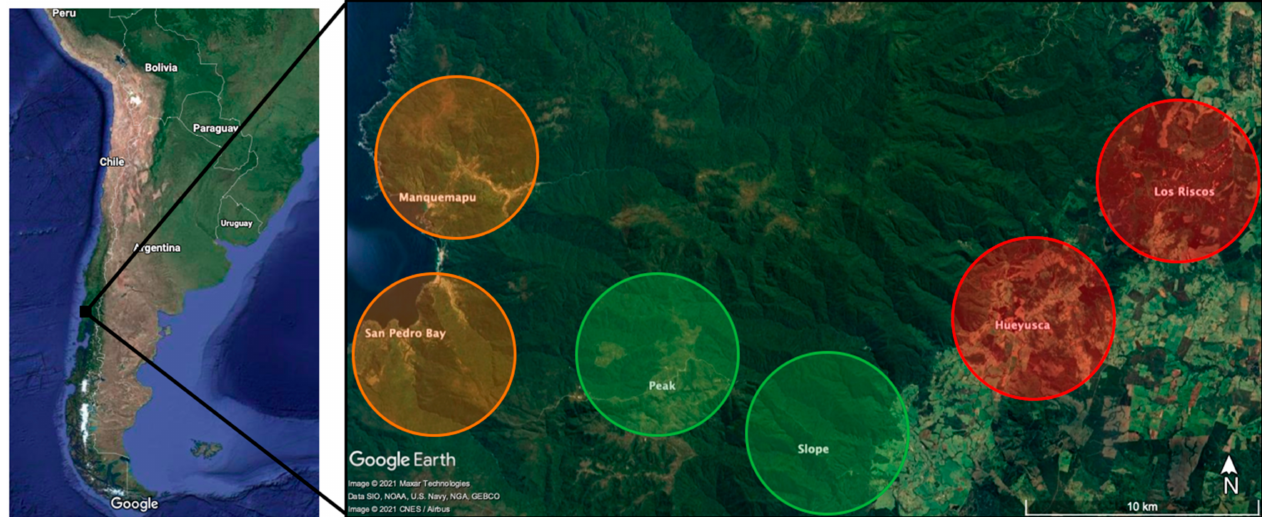
Figure 1. Study area (800 km 2 approximately). Coast locations: Manquemapu and San Pedro Bay (Orange). Mountain range locations: peak and slope (Green). Pre-mountain range locations: Hueyusca and Los Riscos